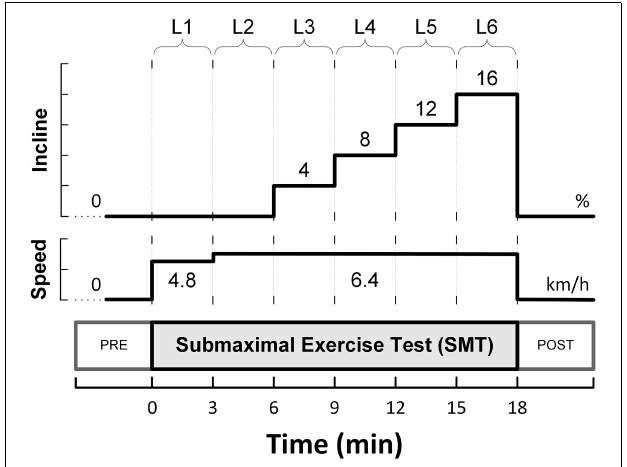
FIGURE 1 | Schematic representation of the six-level submaximal exercise test